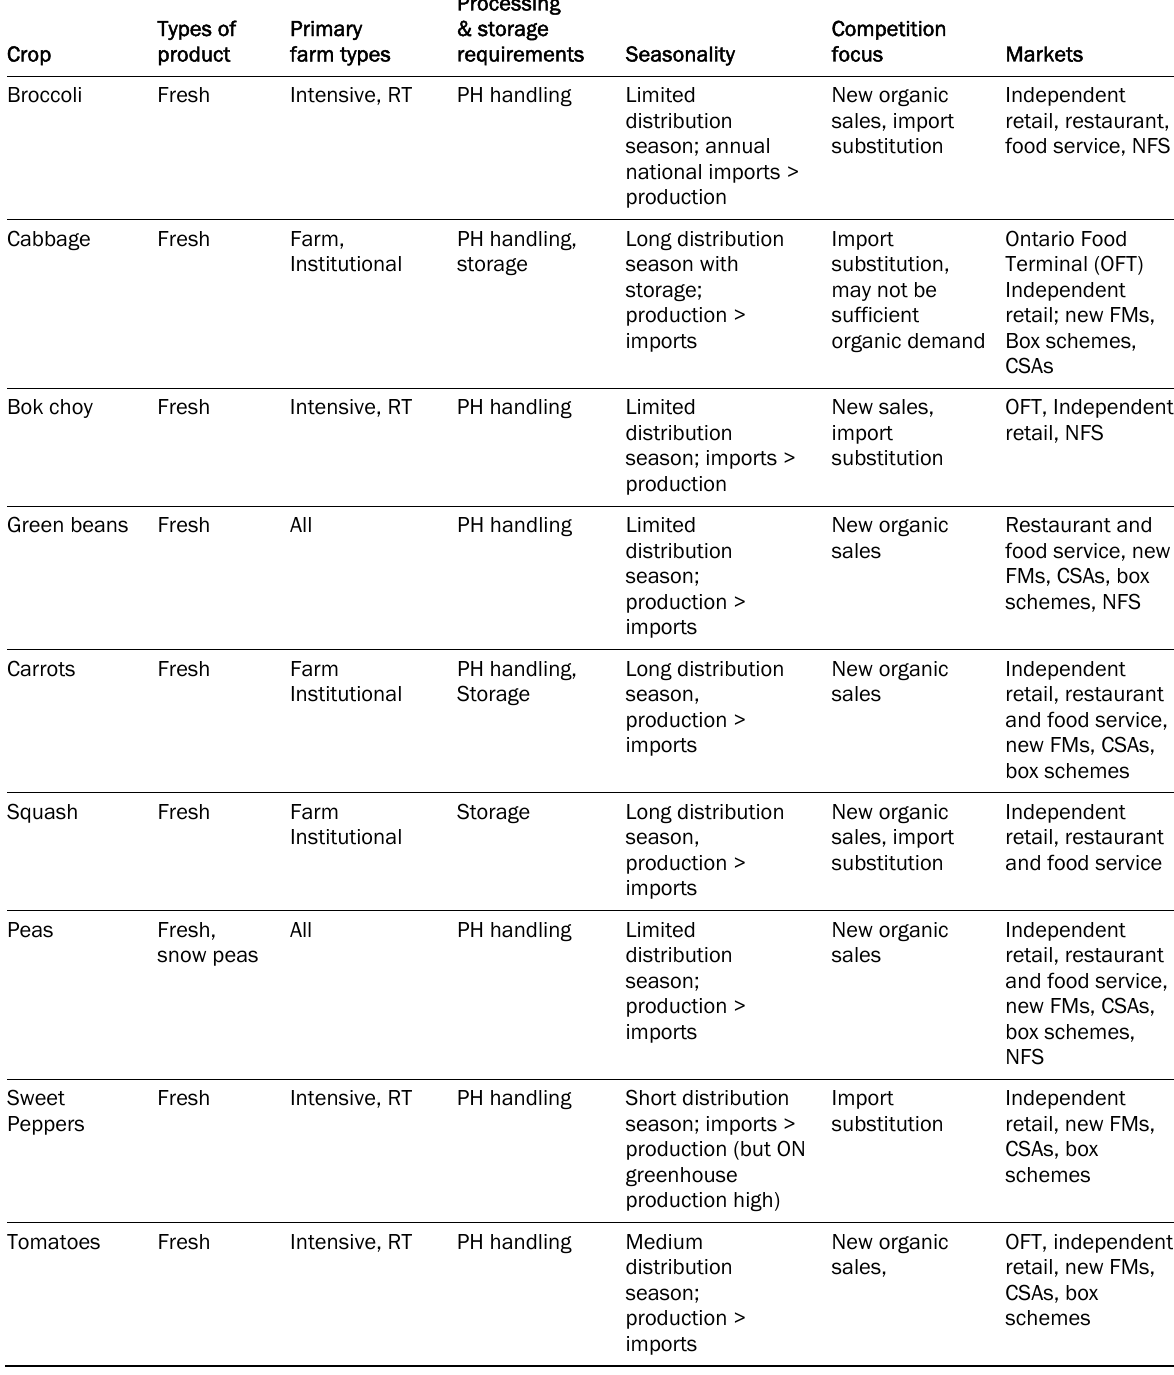
Table 6. Production and Marketing Considerations (see key to abbreviations at bottom of table)